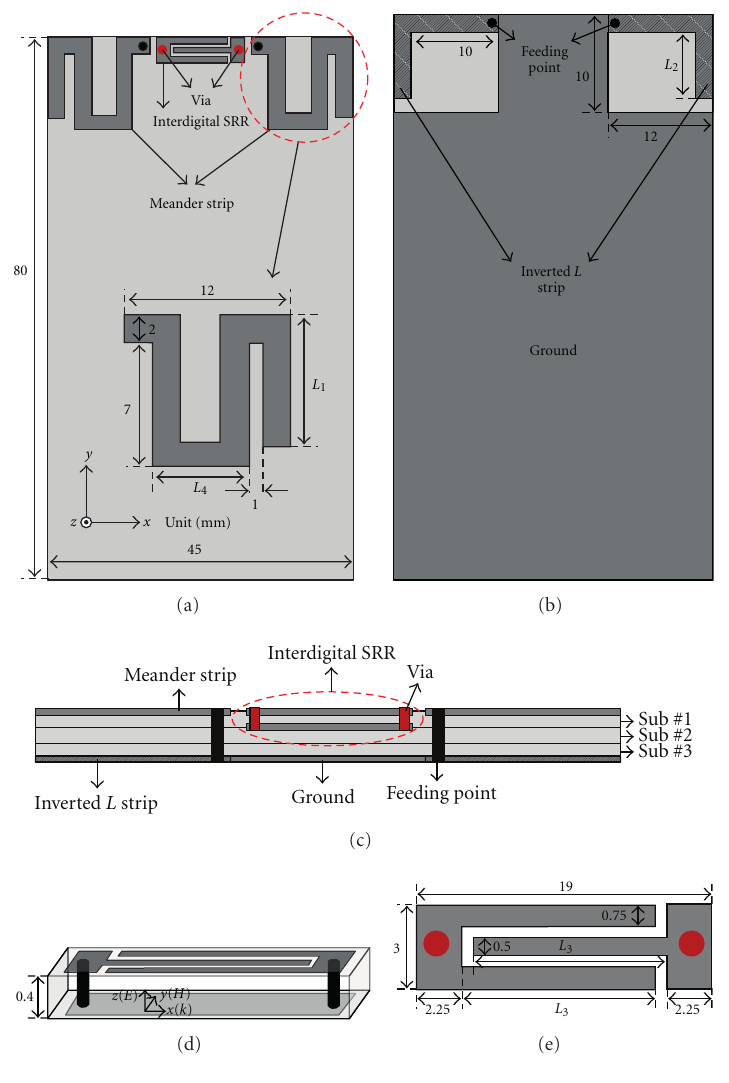
Figure 1: The proposed antenna structure: (a) top view, (b) bottom view, (c) side view, (d) over view of the interdigital SRR, and (e) top view of the interdigital